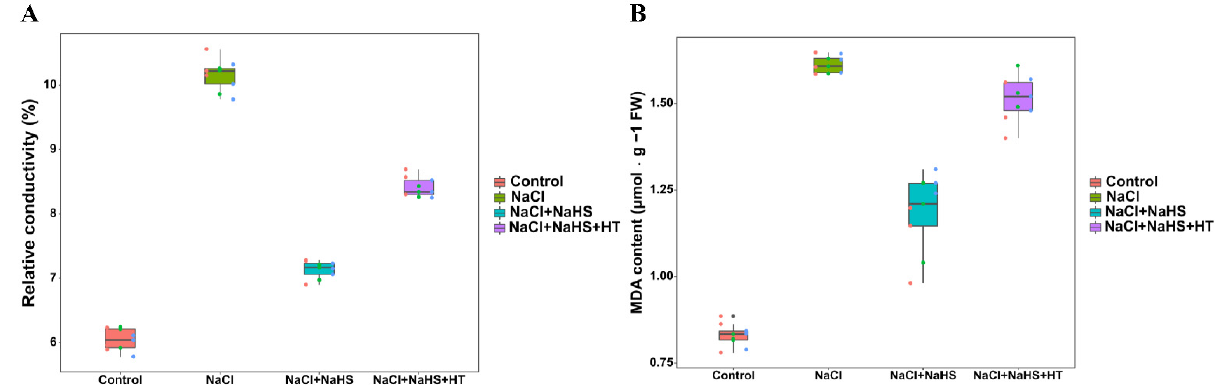
Figure 5. Effect of NaHS application on Relative conductivity ( A ) and MDA content ( B ) of explants species. The primary roots were removed from hypocotyl of 5-day-old seedlings. Explants were incubated for 5 days with distilled water (the control), NaCl, NaCl + NaHS, NaCl + NaHS + HT. Values are means of three independent replicates.